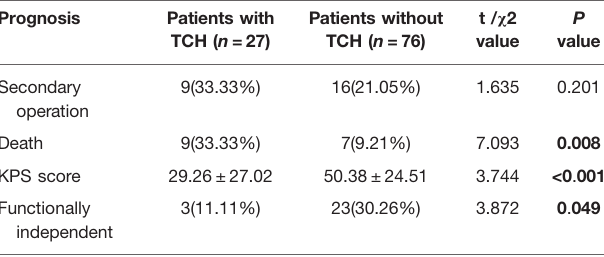
TABLE 4 | Prognosis between patients with TCH and without TCH.